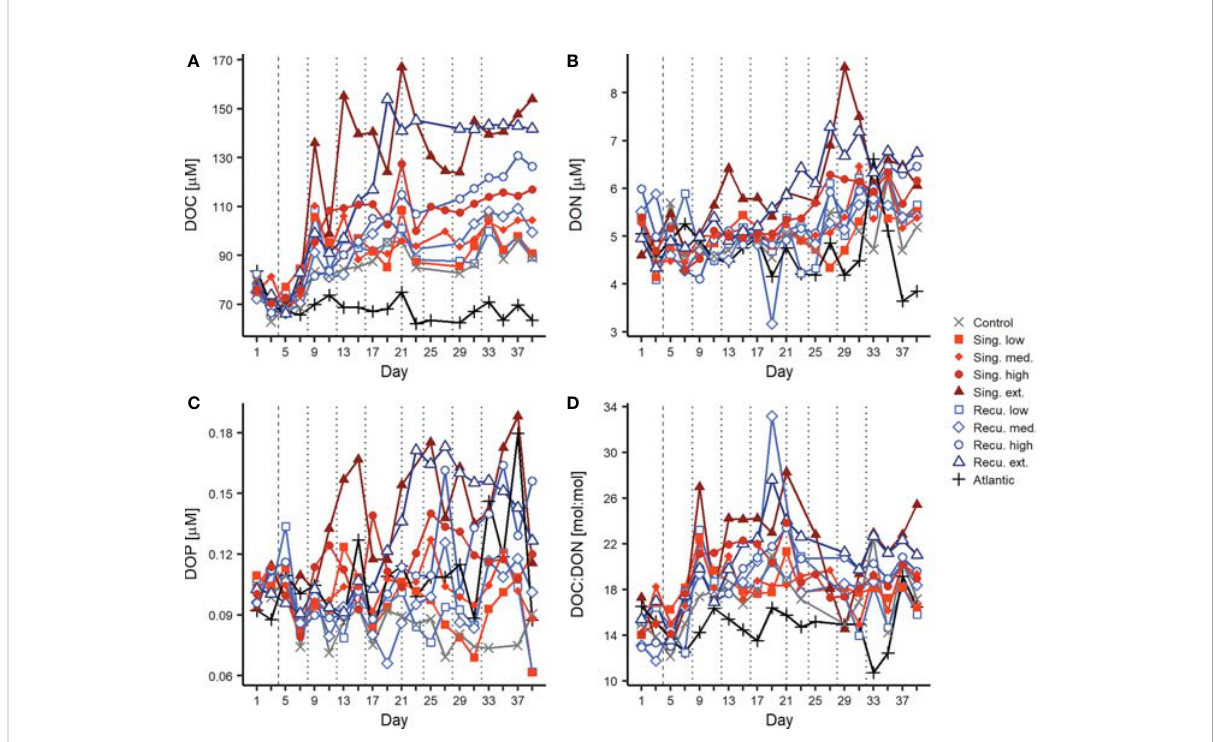
FIGURE 2 Changes in dissolved organic matter concentrations and elemental ratios ratios during the experiment. Temporal evolution of (A) DOC, (B) DON, (C) DOP, (D) DOC : DON. Vertical lines indicate deep water additions of singular (dashed, day 4) and recurring (dashed and dotted) treatments. Results for DOC : DOP and DON : DOP ratios can be found in Figure